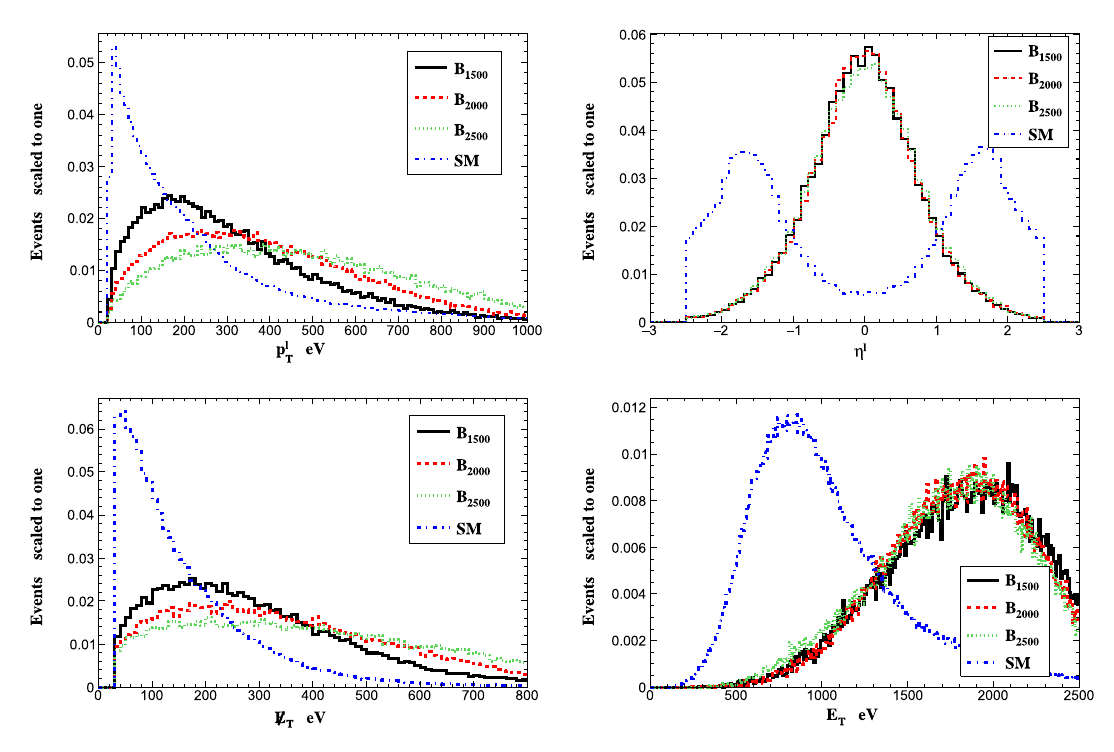
Fig. 5 Same as Fig. 4 but for the (cid:6) 2 bjj + / E T final